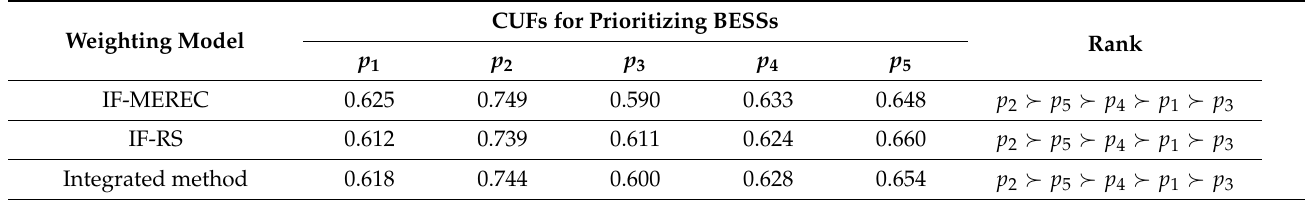
Table A11. The CUF for prioritizing BESSs over different weighting